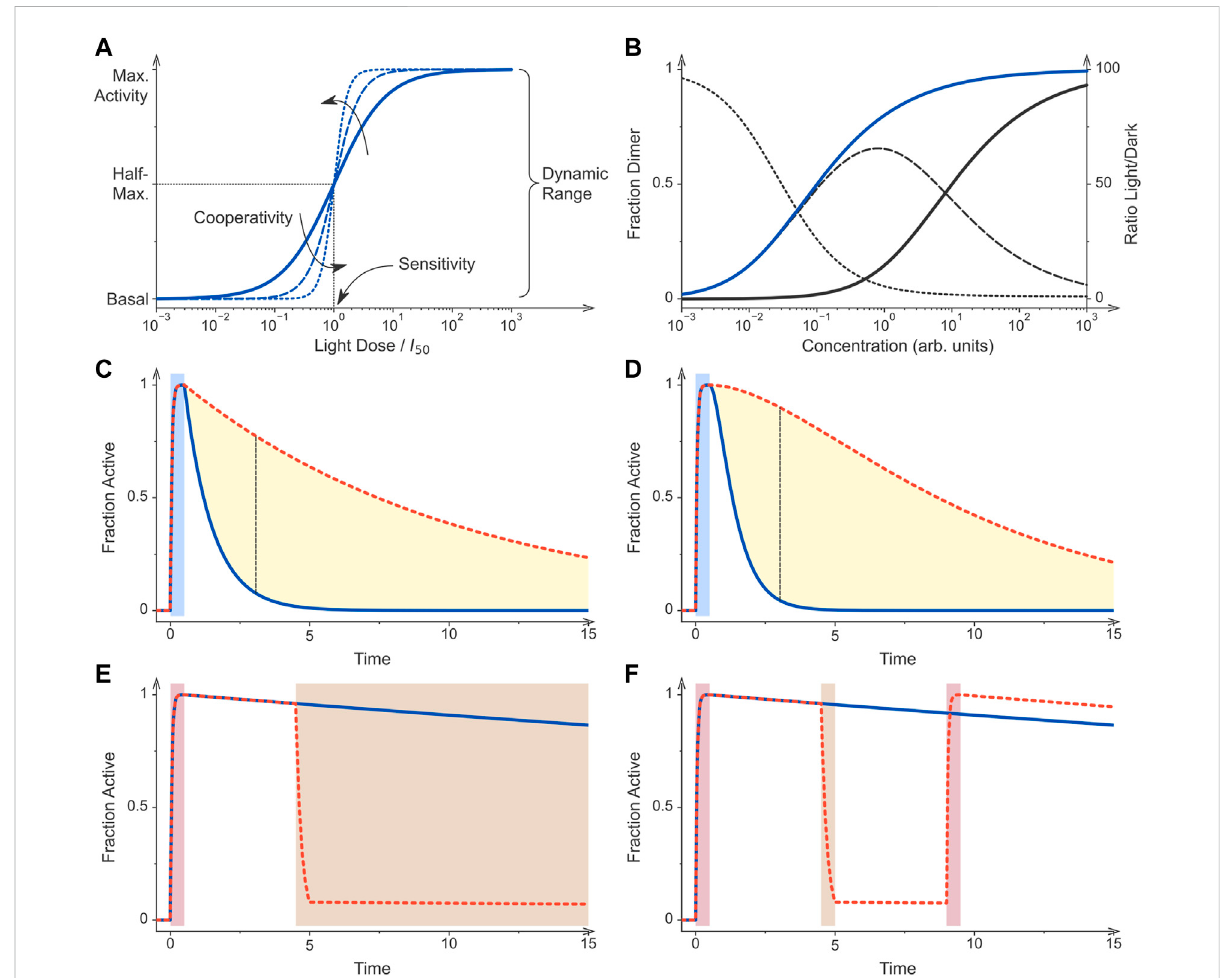
FIGURE 2 Principles of optogenetic control. (A) Sensory photoreceptors and genetic circuits for the light-regulated gene expression in bacteria are characterized by key performance parameters. If all photoreceptor molecules dwell in their low-activity state, the circuit generates a basal output, also denoted as leak activity. Once all photoreceptors are converted to their more active state, maximal activity is generated by the circuit. The ratio of maximal over basal activity is referred to as the dynamic range or regulatory ef fi ciency/factor. Optogenetic circuits differ in their light sensitivity, commonly reported as the light dose required for half-maximal activation, and the cooperativity of their response to illumination. The solid curve shows the response of a non-cooperative optogenetic circuit where I 50 is the light dose at which half-maximal activation occurs. By contrast, the dashed and dotted curves denote circuits that respond to light cooperatively with Hill coef fi cients of 2 and 4, respectively. (B) Many optogenetic tools for controlling bacterial gene expression rely on light-dependent dimerization equilibria. Associating photoreceptors exhibit a lower dissociation constant under blue light ( K D = 0.1, blue curve) than in darkness ( K D = 10, black), thus causing their activation pro fi les to be displacedalongtheconcentrationaxis.Thedashedlinedenotesthedifferenceofthedimericreceptorfractioninlightanddarknessfortheassumed scenarioofa100-foldchangeddissociationconstant(leftscale).Thedottedlineplotstheratioofthedimerfractions(rightscale). (C) Photoreceptors can substantially differ in their dark-recovery kinetics, and for certain classes deliberate residue substitutions near the chromophore modulatethese kinetics.Afterinitialstimulationbylight(bluebar),agivenphotoreceptorandhenceitsactivityrecoverwithitsintrinsicrateconstant.Thedashedred curvesimulatesareceptorthatrecoversatatenthoftherateofthatforthebluecurve.Thedashedblacklinedenotesthetimepointatwhichtheblue and red curves have the maximal difference. (D) As in panel C but for a dimeric photoreceptor which is assumed to be active if at least one of its subunitsdwellsinthelight-adaptedstate.Afterilluminationceases,therecoveryofactivityishencesigmoidalratherthanexponential.Asacorollary, the maximal difference between the two simulated photoreceptors which differ in their dark-recovery rates by a factor of ten is larger than in scenario C (dashed black line). (E) Certainphotoreceptor circuits are sensitive to a second stimulus e.g., light ofa differentcolor, achemicalinducer, orchangesintemperature(Dietleretal.,2021;Romanoetal.,2021).Initialphotostimulation(redbar)canbecounteractedbysubsequentapplication of the second signal (brown bar). (F) Photochromic photoreceptors, e.g., phytochromes, can be reversibly and repeatedly toggled between their dark-adapted and light-adapted states by two colors of light. These photoreceptors thus constitute a special case of scenario (E) . Following initial photostimulation (red bar), the system can either recover in darkness (blue curve) or be actively returned to the initial state by illumination at desired times (brown bar, red dashed curve). All simulations were conducted with Fit-o-mat (Möglich,